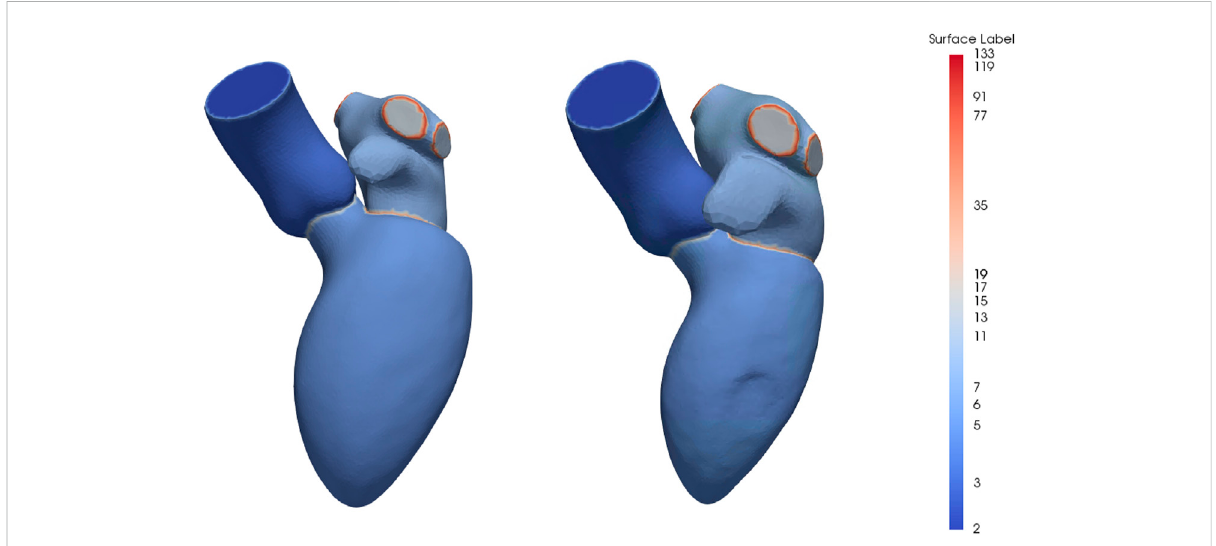
FIGURE 3 Meaninstanceofthegeneratedstatisticalshapemodelsoftheleftheartchambersforthediastolicphases(left)andfullcardiaccycle(right).The labels are prime numbers representing the different structures and the boundaries are obtained by multiplying the labels of the adjoining structures. Speci fi cally, the aorta, left ventricle and left atrium are represented by labels 3, 5 and 7, respectively, resulting in labels 15 for the aortic annulus and label 35 for the mitral annulus.